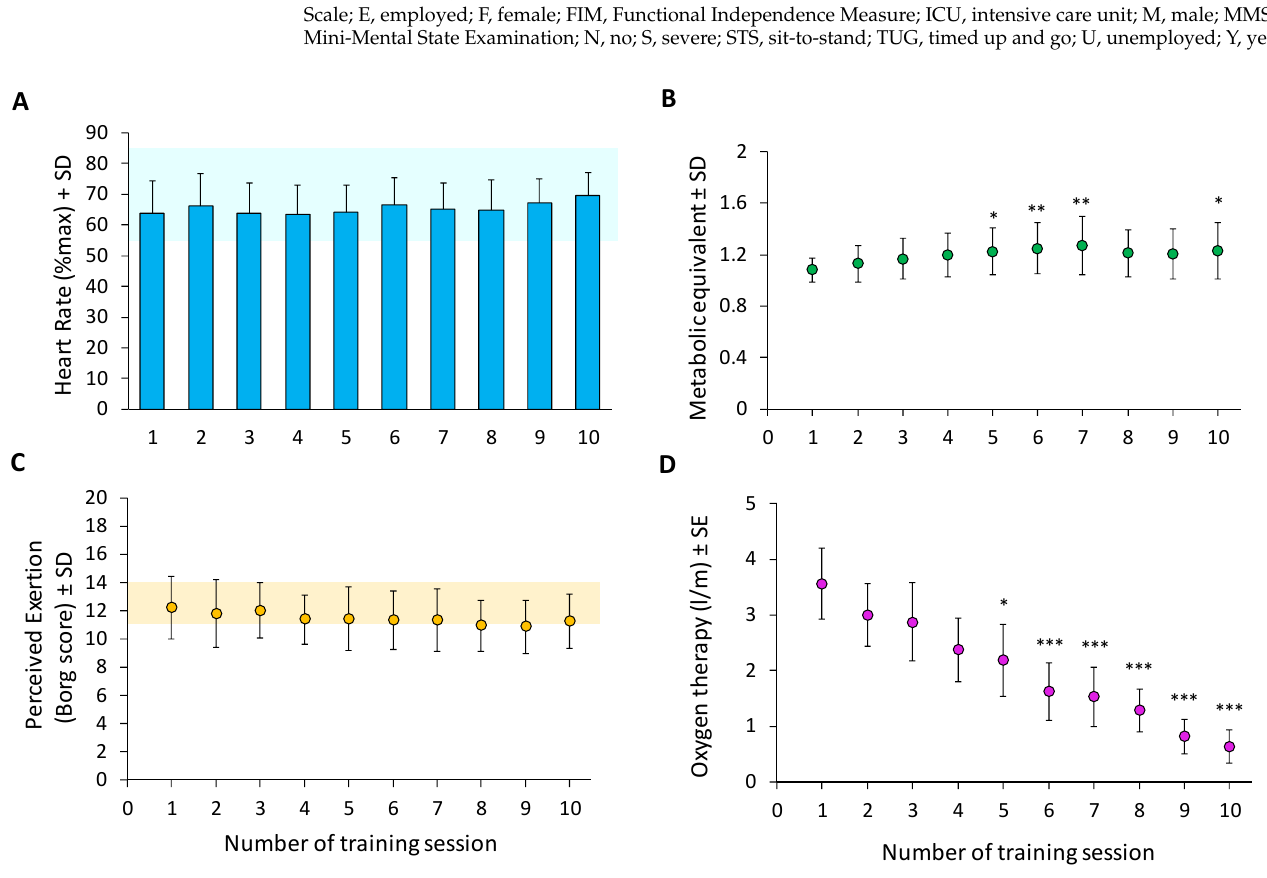
Figure 2. Characteristics of aerobic exercise in training group (n = 16).Both the heart rate ( A ) and the rating of perceived exertion assessed with the Borg Scale ( C ) did not significantly change across the training sessions; this demonstrated that patients with subacute COVID-19 performed a moderate- intensity level of activity, as indicated by the light blue ( A ) and orange bars ( C ), respectively. The metabolic equivalents (METs) ( B ) partially improved across the training sessions, but their mean value across the sessions remained always below the level of 3 METs, thus suggesting that the participants performed a light-intensity physical activity. Oxygen therapy ( D ) significantly decreased from session 5 to 10, compared with day 1 of the training.Asterisks refer to the comparison between subsequent days and the first day of the training. *, p < 0.05; **, p < 0.005; ***, p < 0.0005.